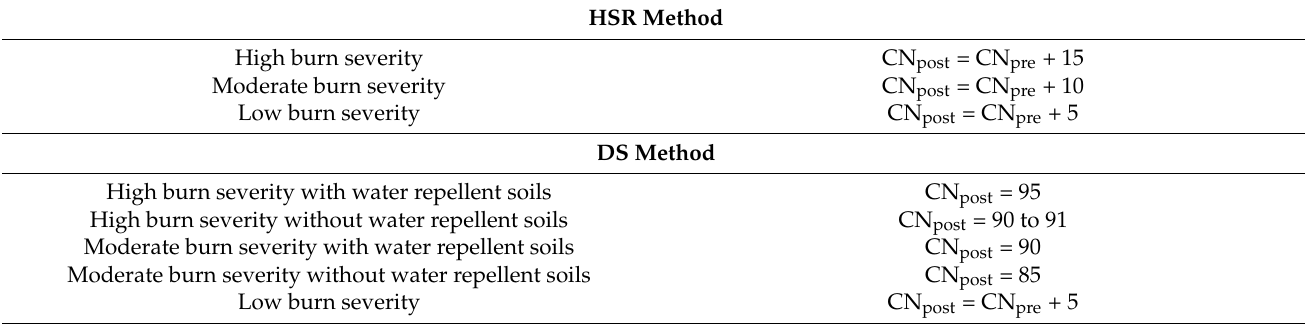
Table 4. Post-fire CN as a function of burn